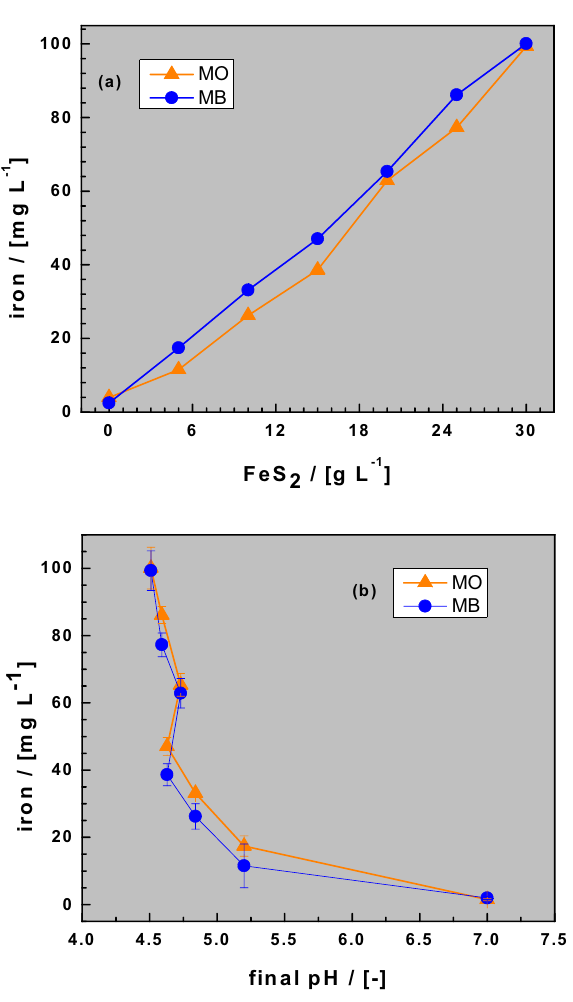
Figure 2. Changes of the iron concentration as function of the pyrite dose ( a ) and the final pH value ( b ). Experimental conditions: V = 20 mL, m iron = 0.1 g, m sand = 0.5 g, m pyrite 0 to 0.6 g, and t = 41 d. The lines are not fitting functions, they simply connect points to facilitate